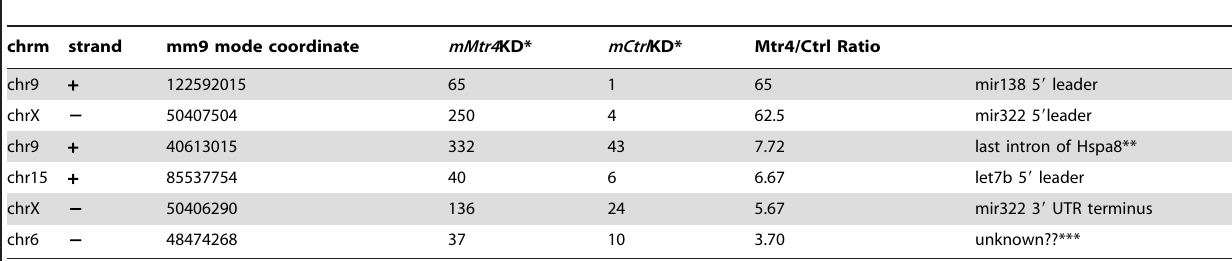
Table 2. Adenylated RNAs that accumulate in mMtr4 KD.